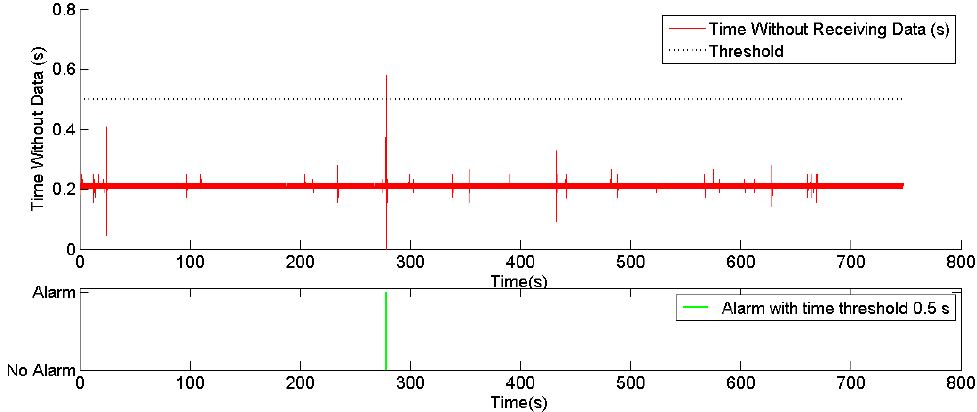
Figure 11. Alarms generated by the service disruption supervisor.